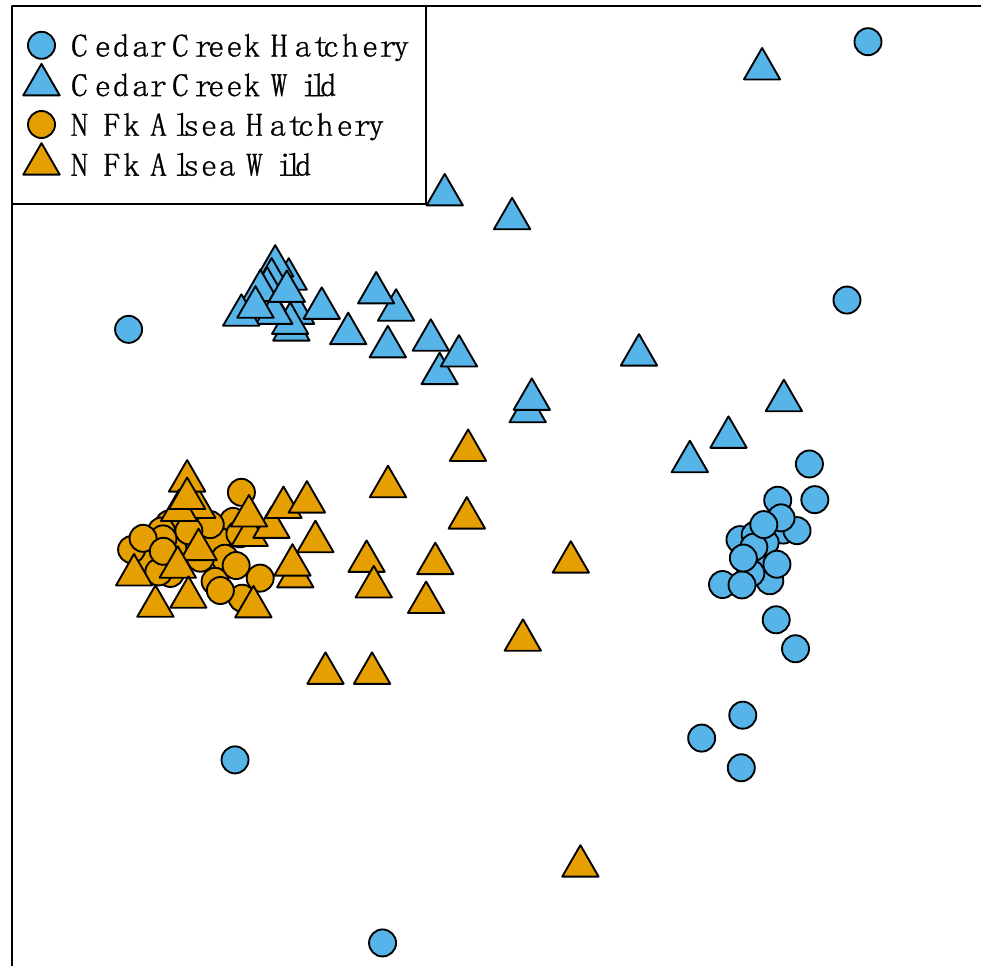
Figure 5. The gut microbiomes of traditional hatchery-reared steelhead differ compositionally compared to their wild broodstock counterparts. NMDS plot showcasing the differences between hatchery broodstock and wild broodstock gut microbial samples (PERMANOVA R 2 = 0.29, p < 0.01) as well as differences between Cedar Creek Hatchery and North Fork Alsea Hatchery locations (PERMANOVA R 2 = 0.07, p < 0.001). Stress = 0.13. Visually, there is separation between wild steelhead gut microbial composition and hatchery steelhead gut microbial composition within their respective river basins.